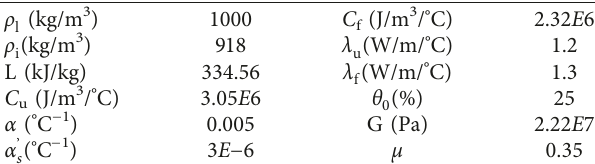
Table 1: Main computational